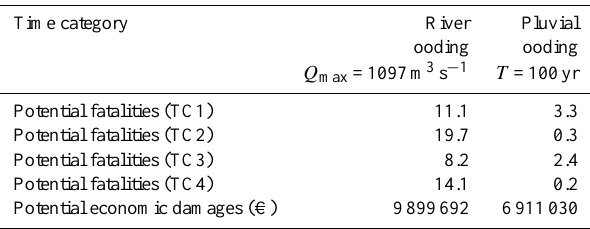
Table 7. Example of estimated potential fatalities and economic damages for the Base Case .